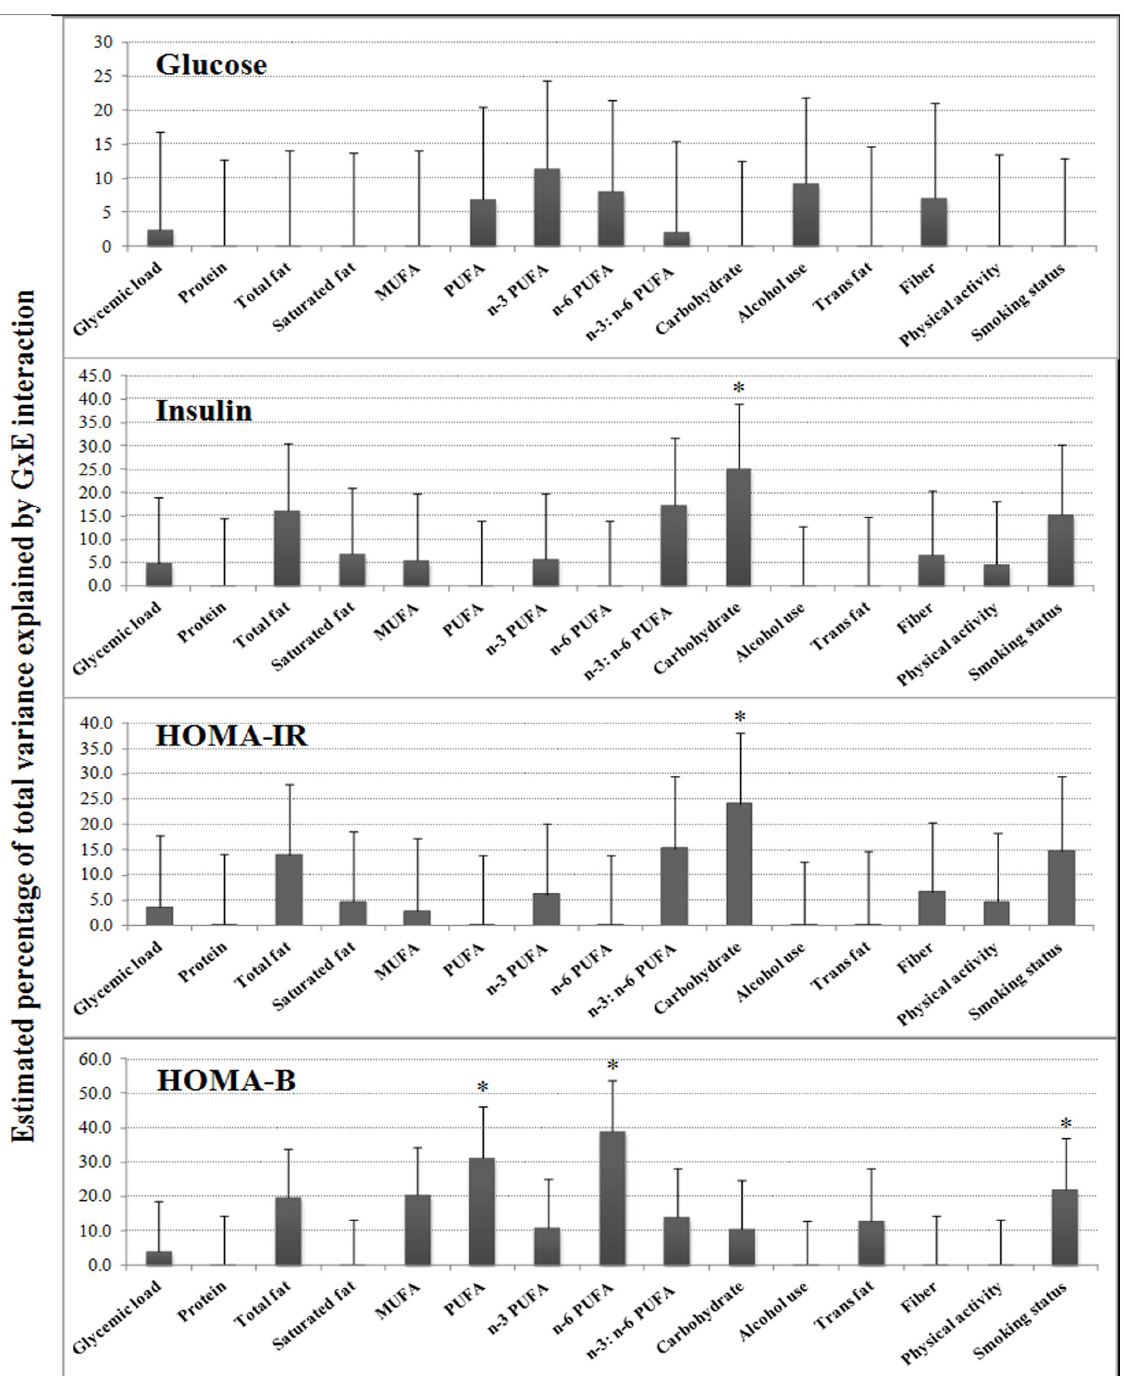
Figure 1. Estimation of GxE variance of 15 dietary and lifestyle factors for four diabetes-related traits. The GxE variance is shown as the percentage of the total phenotypic variance of each trait. * P , 0.05 indicates nominal significant contribution to total variance. doi:10.1371/journal.pone.0077442.g001 ( Table 2 , Figure 1 ). Another environmental factor that was a smoking status, which accounts for 22.0% of total HOMA-B variance ( P -nominal= 0.055) ( Table 2 , Table S4 ).